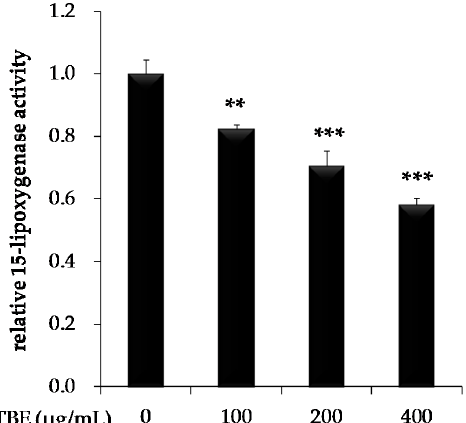
Figure 3. Effect of TBE on 15-lipoxygenase (15-LOX) activity. 15-LOX was mixed with arachidonic acid in the absence or presence of TBE. The absorbance of hydroperoxides produced by 15-LOX from arachidonic acid was measured at 490 nm. Values are means ± SD ( n = 3). ** p < 0.01, *** p < 0.001, compared to untreated control group.